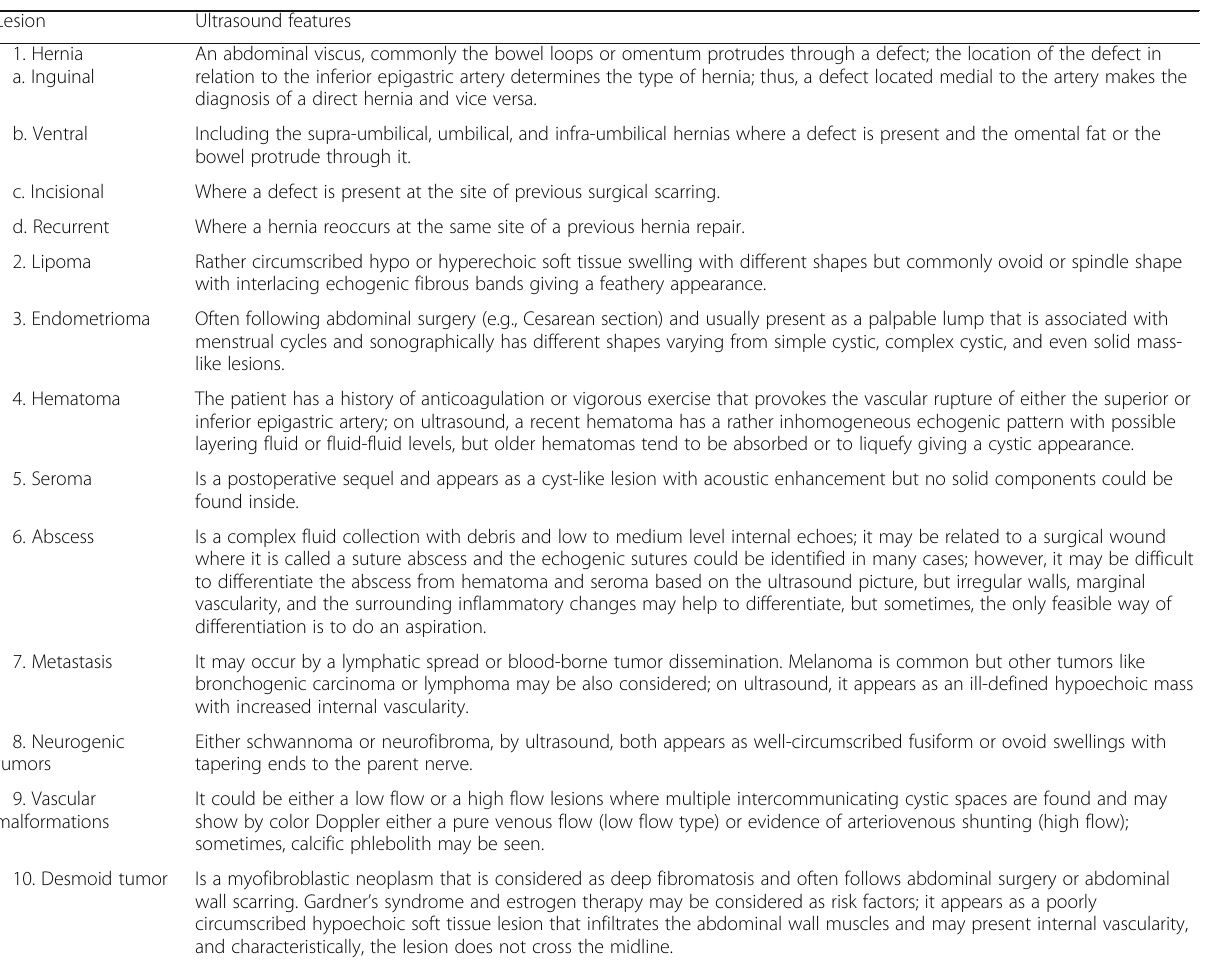
Table 1 A spectrum of the abdominal wall lesions with the demonstration of their ultrasound features [4 – 6, 9, 11]